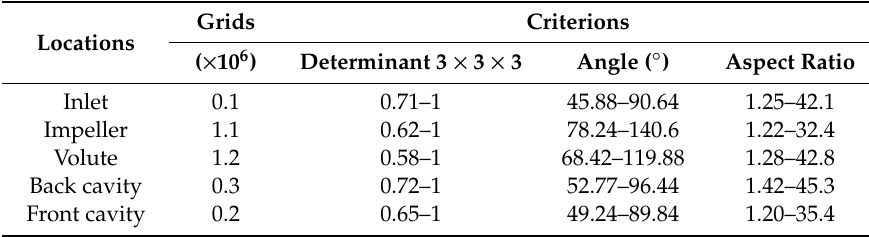
Table 4. Details for the structured grid scenario